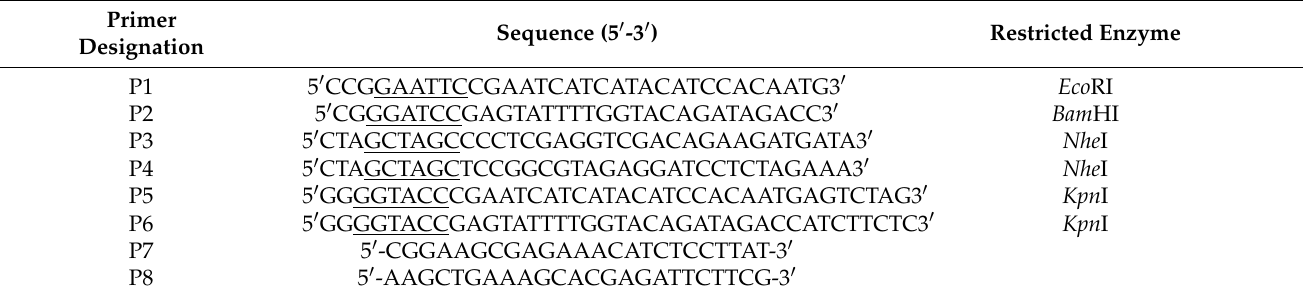
Table 1. Primers used in this